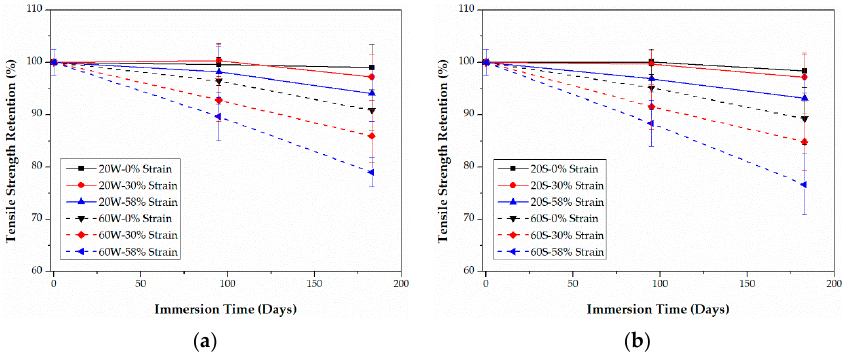
Figure 9. Retention of the tensile strength of epoxy-based CFRPs immersed in distilled water ( a ) and seawater ( b ) for 6 months, respectively.